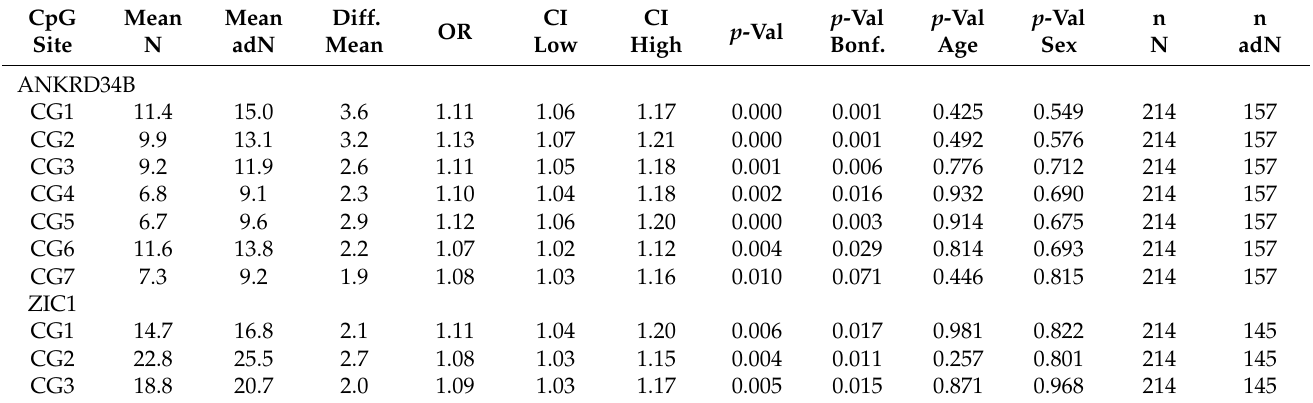
Table 2. Results of CpG site specific logistic regression analysis for age and sex adjusted comparison of DNA-methylation in normal autopsy (N) and tumor adjacent normal kidney tissue samples (adN).